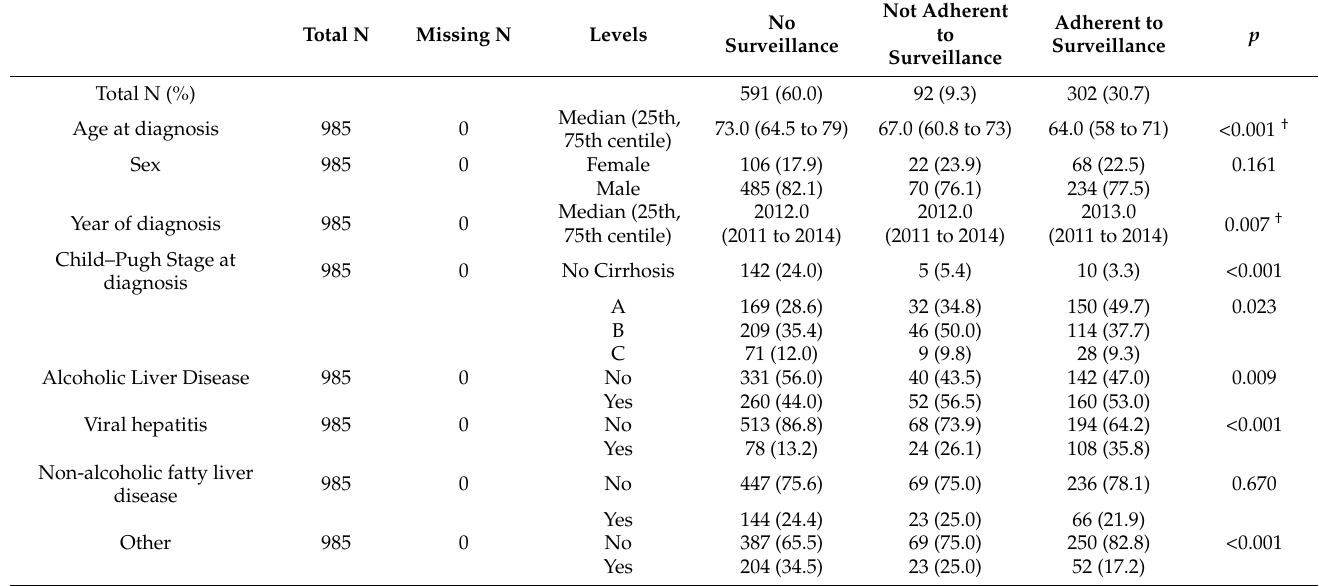
Table 1. Patient characteristics by surveillance adherence group.